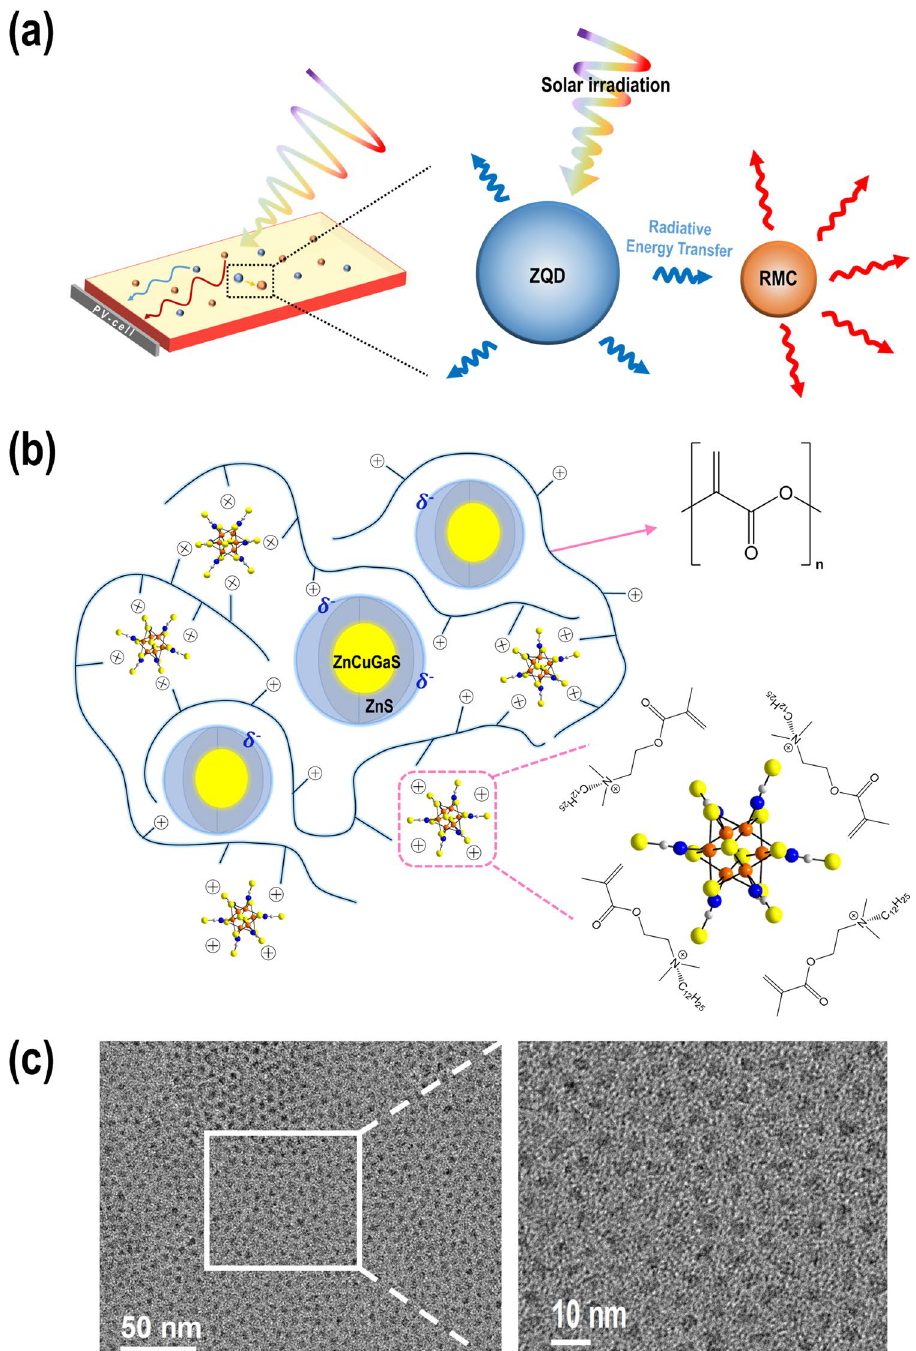
Figure 1. ( a ) Schematic representation of the dual-luminophore LSC system showing energy transfer between luminophores. ( b ) Schematic representation of RMC- and ZQD-embedded polymer waveguide. Organic dMDAEMA + cations were polymerized such that the metal cluster dyes were anchored on the polymer chain without cluster–cluster contact in the PMMA matrix. ( c ) TEM image of ZQD core/shell quantum